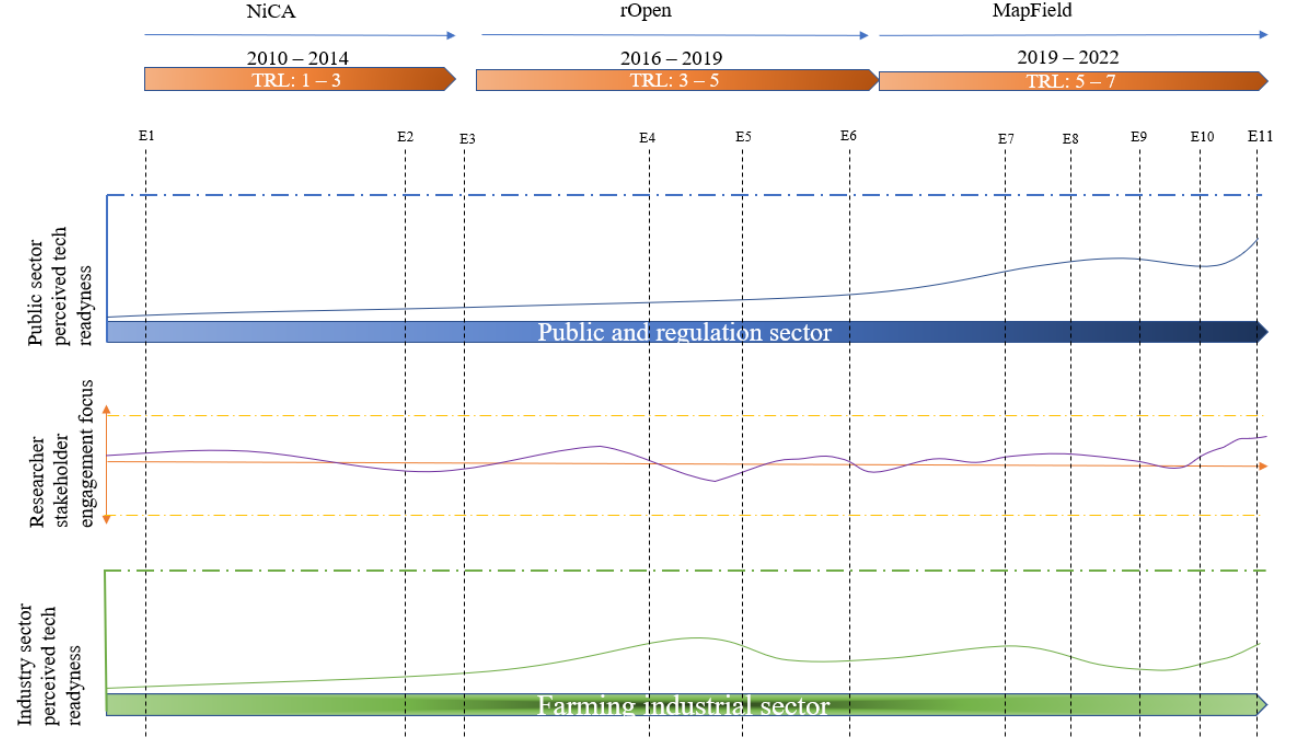
Figure 1. Key events for stakeholder engagement, stakeholder attention, and stakeholder attitudes. The diagrams show the level of perceived readiness from the public sector (top), com- pared with that of the farming industry (bottom). These ranged from a low to a medium level. The middle diagram outlines the projects’ focus for stakeholder engagement activi- ties (upper or lower orientation), as well as the intensity of the stakeholder engagement activities. The centerline in the middle diagram indicates an equal distribution between the farming industry and the public sector. The events (E1 through E11) were related to their context, and are described in detail in the following sections; relevant parts that are related to stakeholder engagement are emphasized in bold